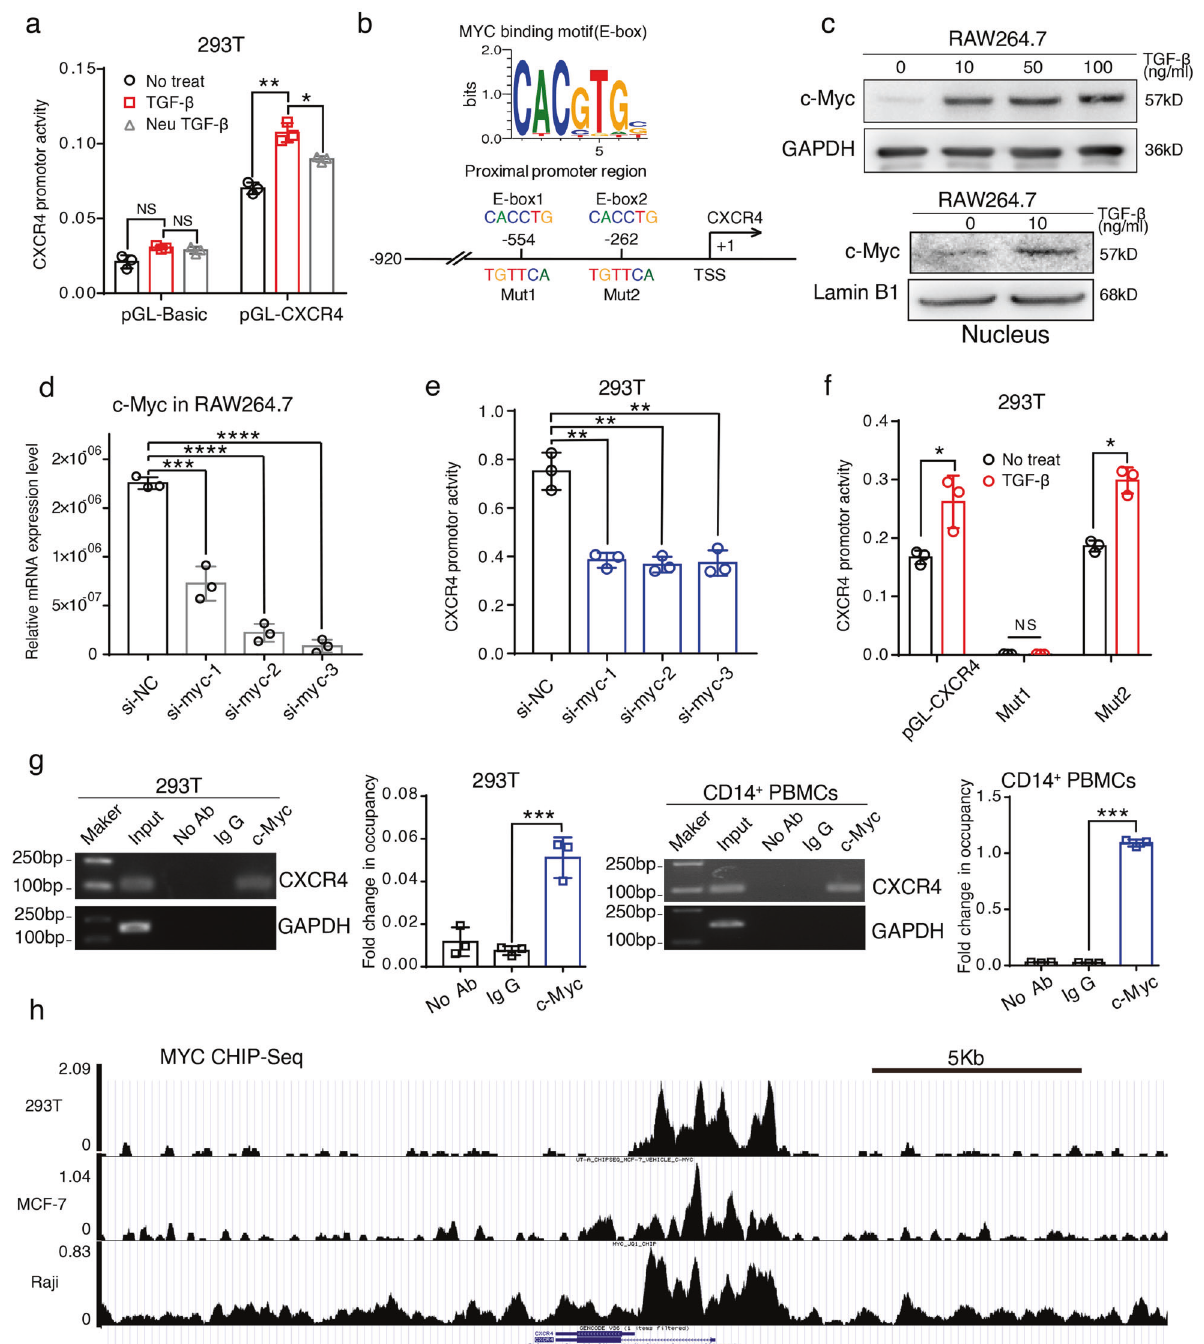
Fig. 4 TGF- β promotes polarization of M2 macrophages and induces its CXCR4 expression via c-Myc . a CXCR4 expression is regulated by TGF- β and suppressed by TGF- β Neutralizing antibody. b Upper panel: MYC binding motif. Lower panel: bioinformatic analysis identi fi ed 2 putative E-box cis-elements (E-box1 and E-box2) in CXCR4 proximal promoter region. c TGF- β induced MYC expression in a dose-dependent manner and promote MYC translocation into the nucleus in RAW264.7 cells. d Utilize qPCR analysis to verify the expression level of c-Myc which is down-regulated using small interfering RNA (siRNA). e Silencing c-Myc inducing CXCR4 promoter activity markedly decreased after co- transfecting c-Myc siRNAs in 293T cells. f Two potential MYC-binding sites are mutated from CACCTG to TGTTCA and marked with Mut1and Mut2 (see Fig. 5b lower panel). Then these mutant plasmids were co-transfected into 293T cells. Results show Mut1 mutated construct abolish the MYC-binding and activation effect at the CXCR4 promoter region. g ChIP-PCR and ChIP-qPCR analysis demonstrated that CXCR4 is a direct target of MYC. The pulled-down DNA was ampli fi ed by RT-qPCR and ordinary PCR with primers which were designed based on the Mut1 site of CXCR4 promoter. h In silico analysis show c-MYC bound and regulated the expression of CXCR4 in 293T, MCF-7, and Raji cancer cell lines.